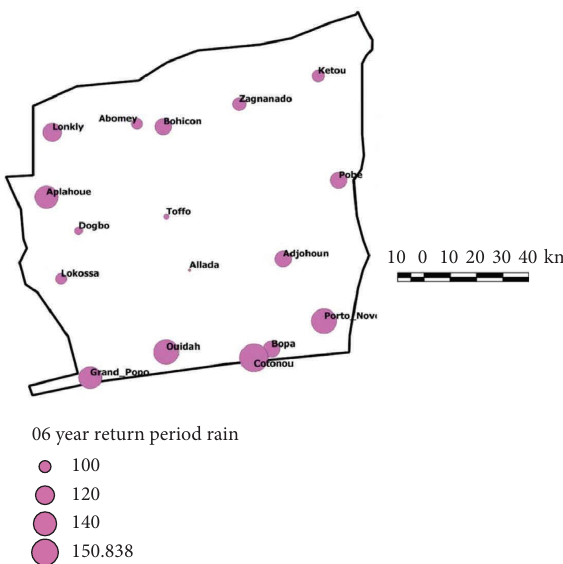
Figure 3: Distribution of 06-year return period rainfall quantiles.